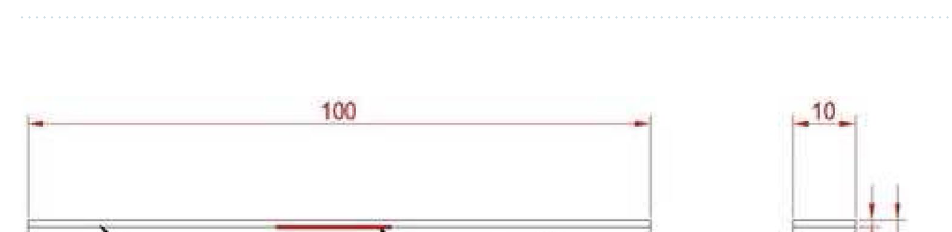
Table 1. Materials properties.